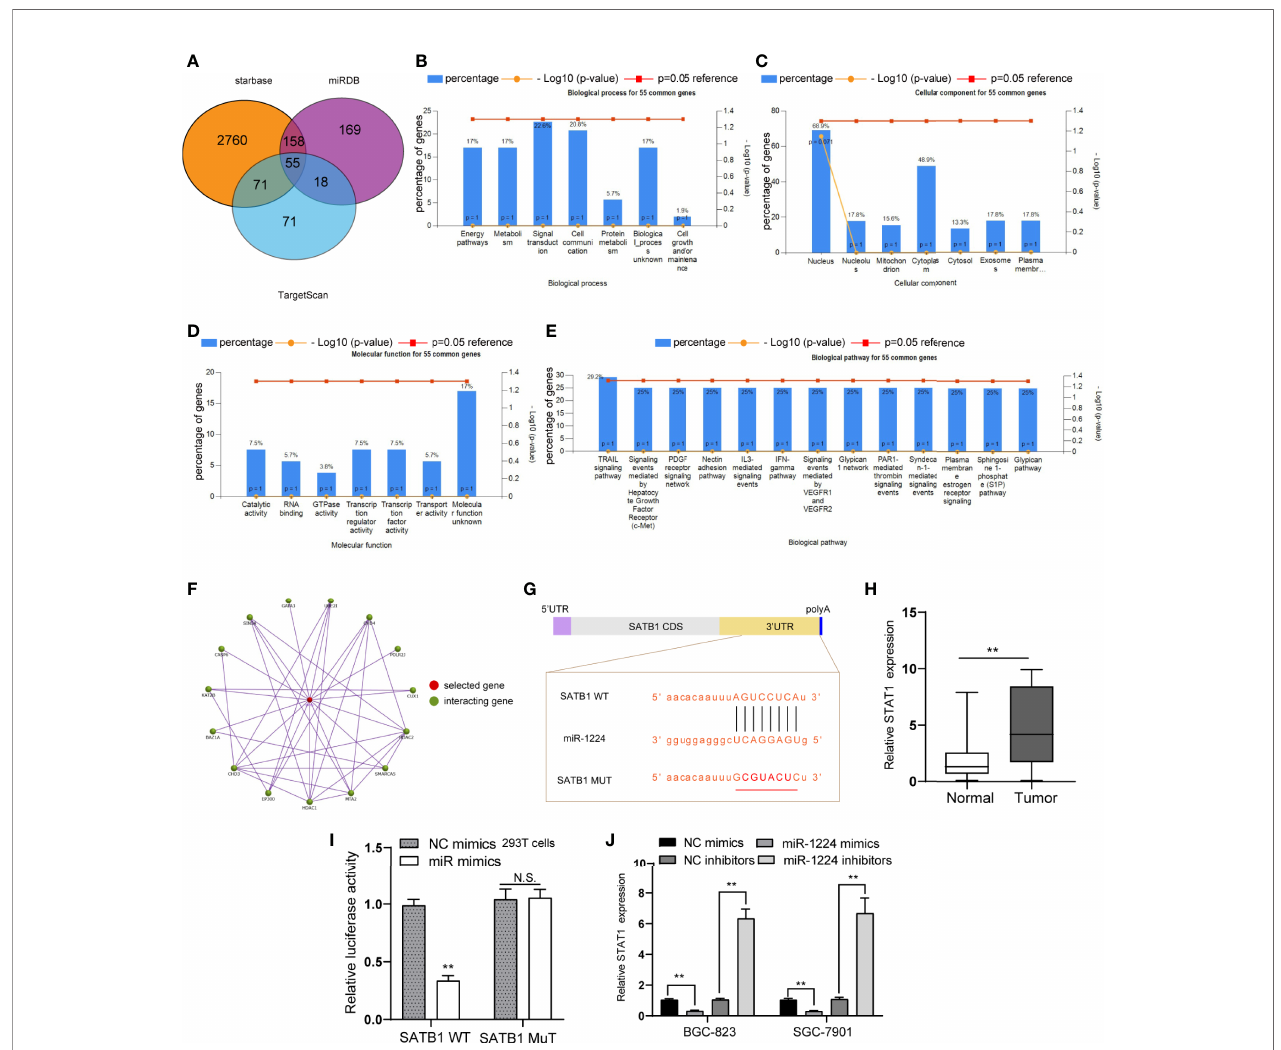
FIGURE 5 | SATB1 is a direct target of miR-1224 in GC cells. (A) Venn diagram of the potential target genes of miR-1224. (B) Biological processes of the 55 common genes. (C) The cellular components analyses. (D) The molecular functions analyses for the 55 common genes. (E) The biological pathways analyses for the 55 common genes. (F) The SATB1-genes interaction network. (G) miR-1224 and its binding sequence in the wild-type and mutant 3 ’ UTR of SATB1 mRNA. (H) The levels of SATB1 in GC tissues and matched non-tumor samples were determined using qPCR. (I) Luciferase activities con fi rmed that miR-1224 directly targeted SATB1. (J) The levels of SATB1 were determined by qPCR after the transfection of miR-1224 mimics or inhibitors. ** p < 0.01. Experiments were repeated three times with three replicates. Ns, no signi fi